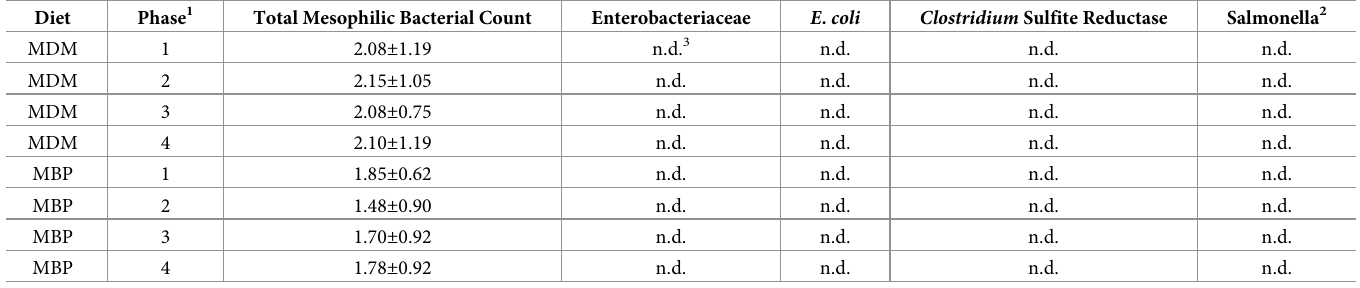
Table 7. Mean counts (mean ± SD log CFU/g) of the main microbial groups) in the two diets (MDM = Mechanically Deboned Chicken Meat diet and MBP = Meat By-Products diet) at different phases. Diet Phase 1